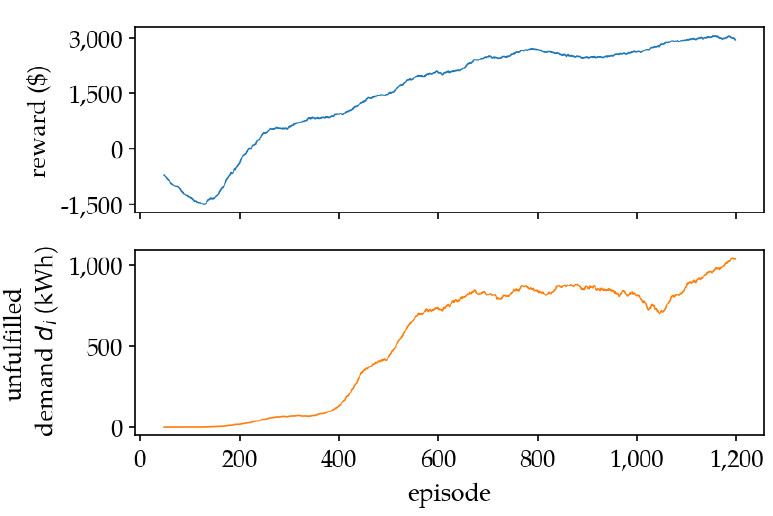
Figure 23. Training curves of the unconstrained model.